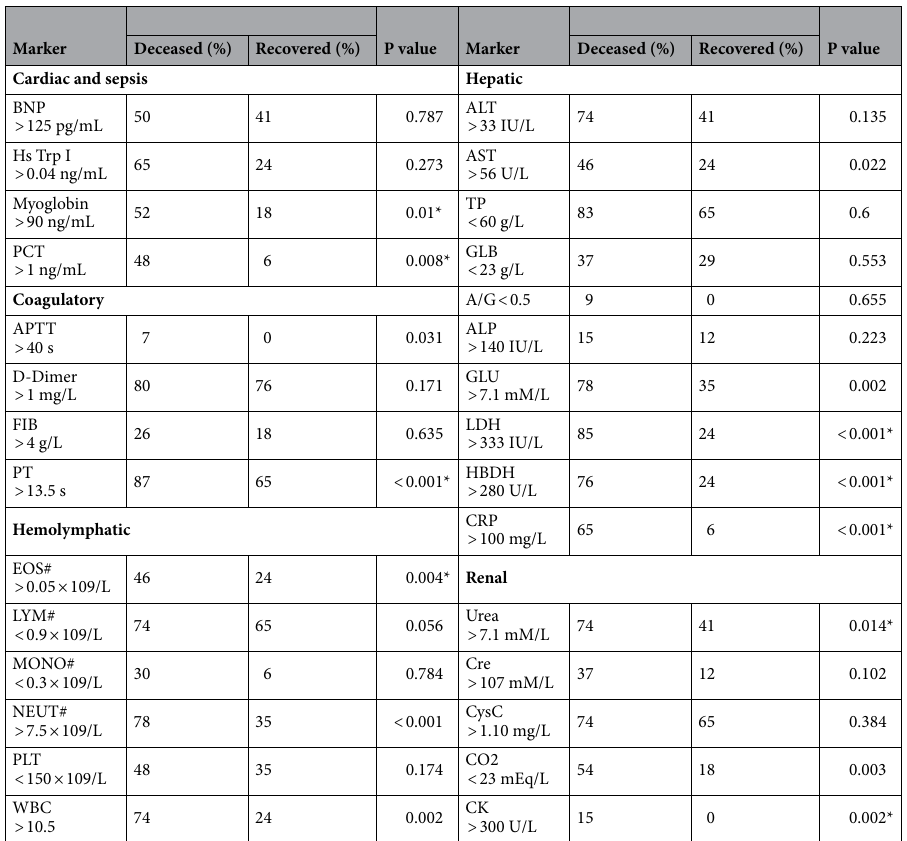
Table 3. Blood chemistry and frequency of rise/fall of biomarkers of 63 critical patients. Deceased (D), Recovered (R), B-Type Natriuretic Peptide (BNP), Hypersensitive Troponin I (Hs Trp I), Procalcitonin (PCT), Activated Partial Thromboplastin Time (APTT), Fibrinogen (FIB), Pro-Thrombin Time (PT), Eosinophil (EOS), Lymphocyte (LYM), Monocytes (MONO), Neutrophil (NEUT), Platelet (PLT), White Blood Cell Count (WBC), Alanine Aminotransferase (ALT), Aspartate Aminotransferase (AST), Total Protein (TP), Globulin (GLB), Albumin/Globulin Ratio (A/G), Glucose (GLU), Lactic Acid Dehydrogenase (LDH), α-Hydroxybutyrate Dehydrogenase (HBDH), C-Reactive Protein (CRP), Uric Acid (UA), Creatinine (Cre), Cystatin C (Cysc), Creatine Kinase (CK). * Levene’s test is significant (p < 0.05), suggesting a violation of the equal variance